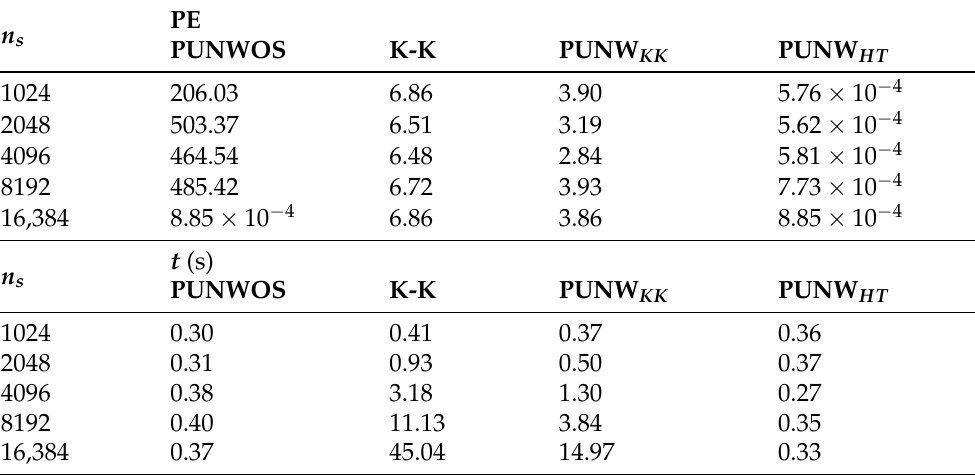
Table 3. Percentage error (PE) and computational time t for the slab with d ef f = 300 nm. PE n s